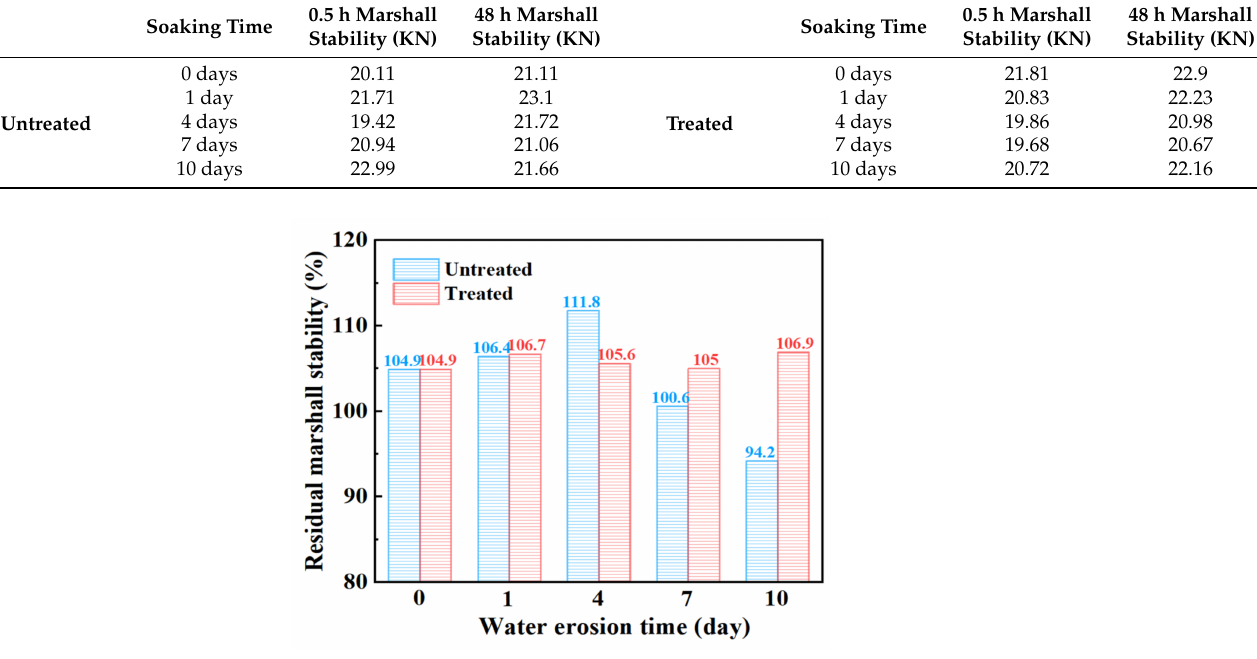
Figure 9. Marshall residual stability of steel slag asphalt mixture with different water erosion